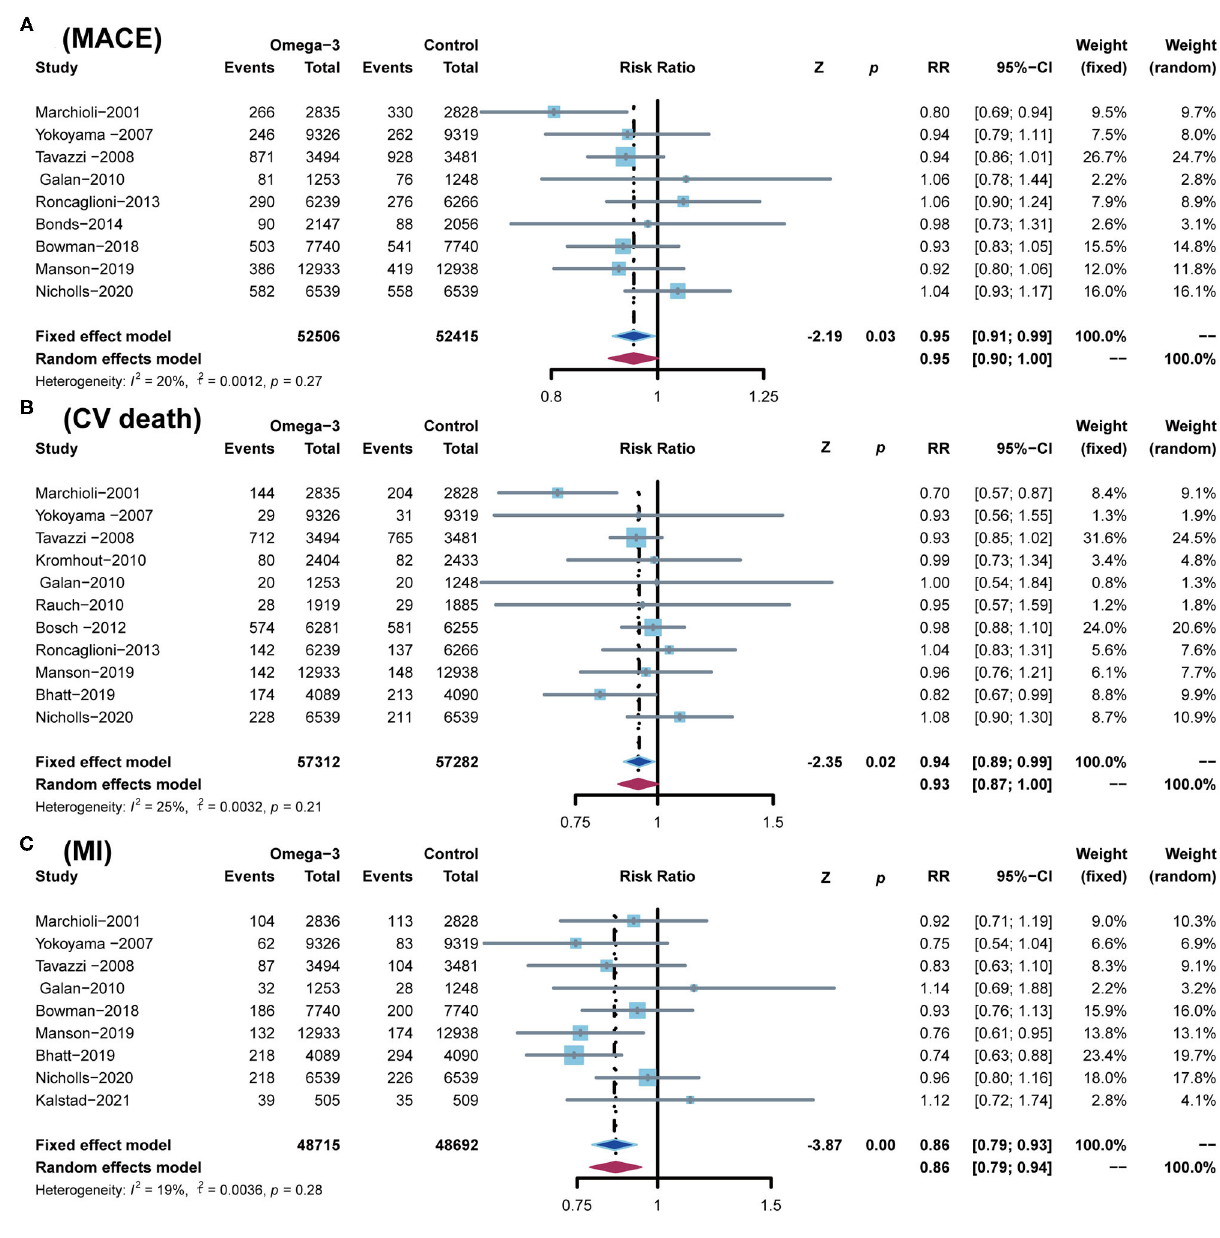
FIGURE 4 | Comparison of omega-3 FA supplementation vs. control group on the risks of (A) MACE; (B) CV death; (C) MI. MACEs, major adverse cardiovascular events; CV death, cardiovascular death; MI, myocardial